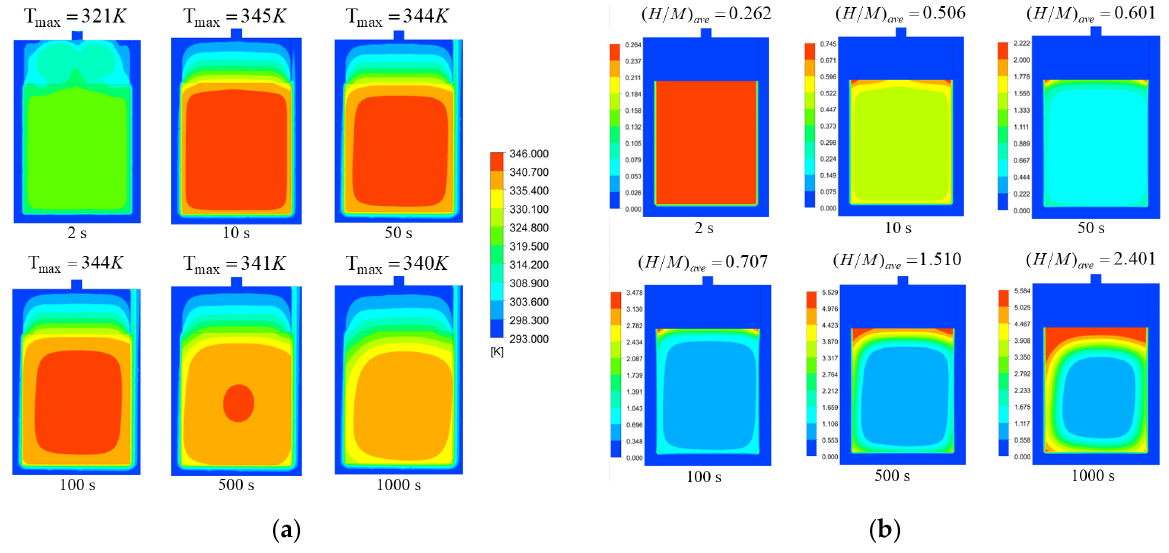
Figure 8. Temperature and hydrogen storage capacity distribution at different times of the reaction tank subjected to an oil coolant flow rate of 0.005 m/s. ( a ) Temperature distribution cloud chart; ( b ) Hydrogen storage capacity distribution cloud chart.